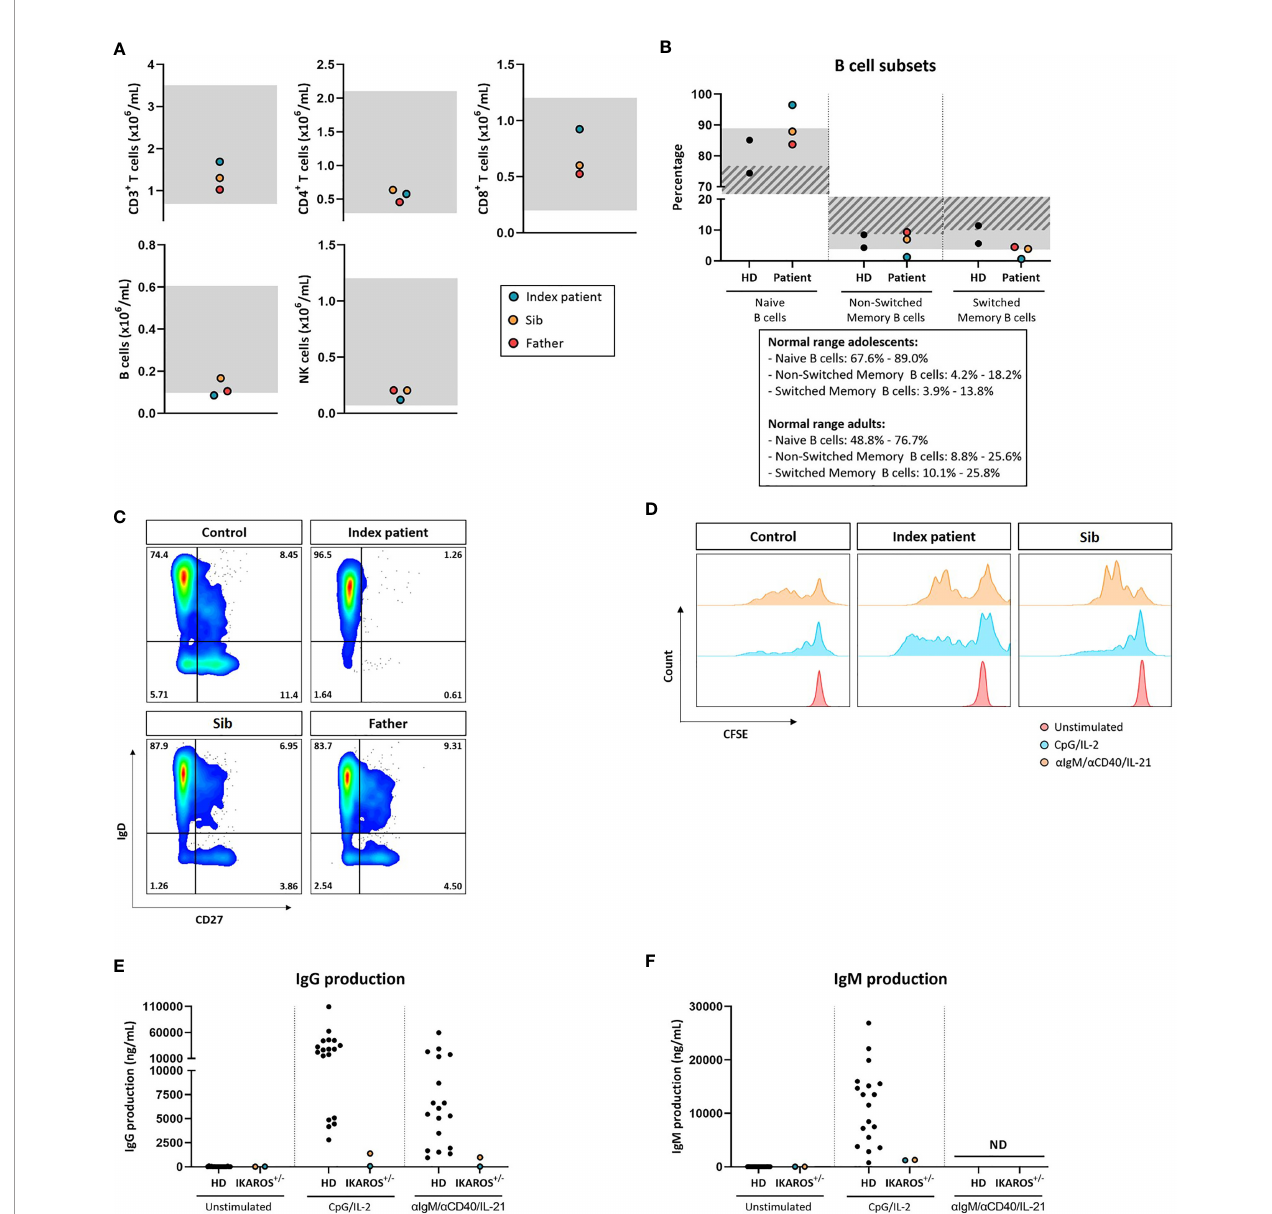
FIGURE 2 | (A) Absolute B-cell, T-cell, and NK-cell numbers. Gray indicates age-dependent normal values. (B) Percentages of naive (CD27 - IgD + ), non-switched memory (CD27 + IgD + ), and switched memory B cells (CD27 + IgD - ) within the total B-cell pool (CD19 + CD20 + ). Gray indicates normal values for adolescents; gray stripe indicates normal values for adults. (C) Representative fl ow cytometry plots of B-cell subsets. (D) Proliferation of B cells measured by CFSE dilution. (E) IgG production in vitro after 20 days of culture in ng/mL measured by ELISA. (F) IgM production in vitro after 20 days of culture in ng/mL measured by